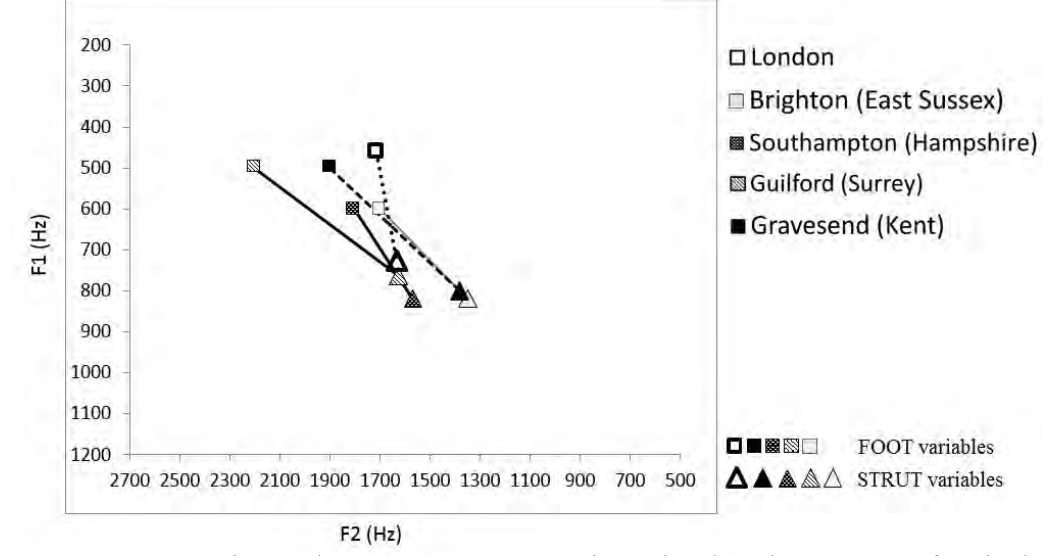
Fig. 1 – The FOOT-STRUT contrast in South and South East accents of England (mean values of the vowels of five young females) The FOOT values F1 = 530 Hz, F2 = 1860 Hz mean mean demonstrate a more fronted and more open realization of the vowel than in RP (F1 = 410 Hz, F2 = 1340 Hz) [3]. But still the phonemic contrast between FOOT and STRUT is very vivid with the average 32% (F1) and 23% (F2) difference between the two